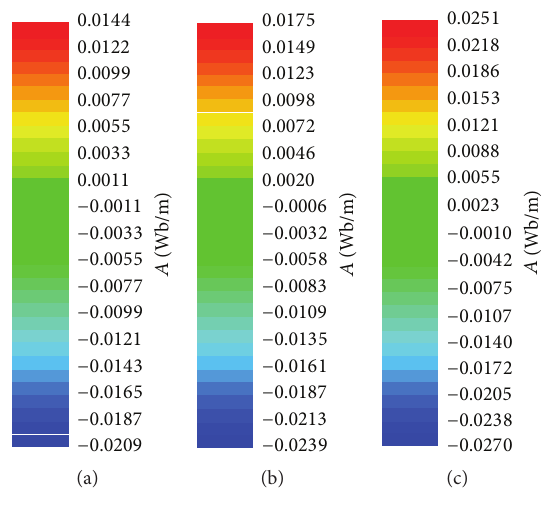
Figure 33: Scale of magnetic